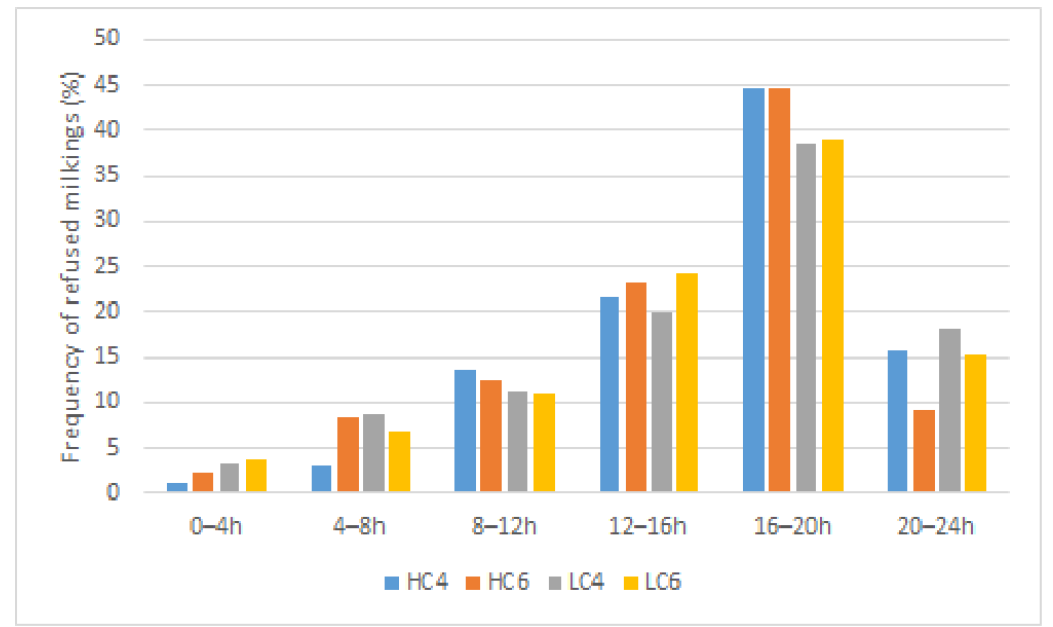
Figure 6. Time schedule of milkings (SM) of the different groups. Abbreviations. HC4, High con- centrate allocation, MMI set at 4 h. HC6, High concentrate allocation, MMI set at 6 h. LC4, Low concentrate allocation, MMI set at 4 h. LC6, Low concentrate allocation, MMI set at 6 h.